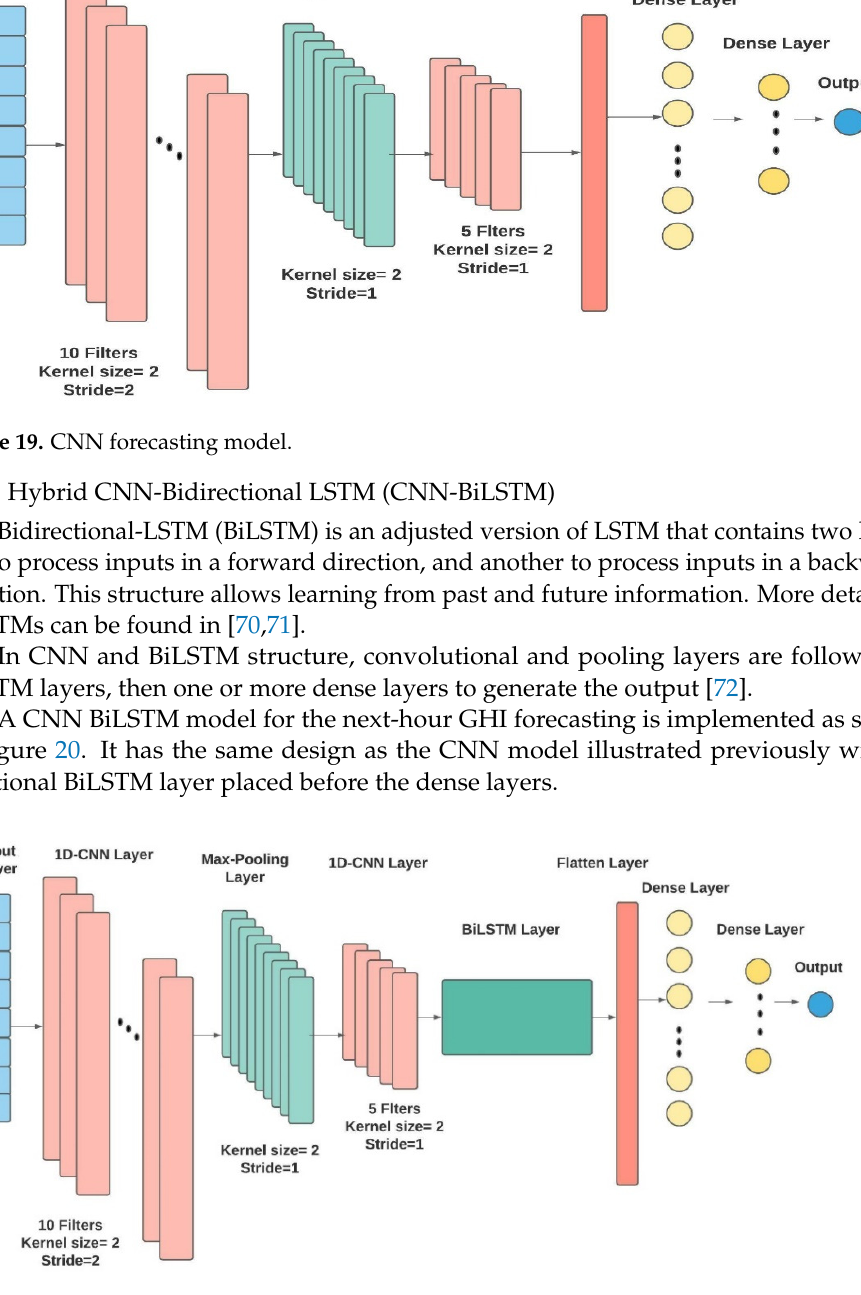
Figure 20. CNN-BiLSTM forecasting model.